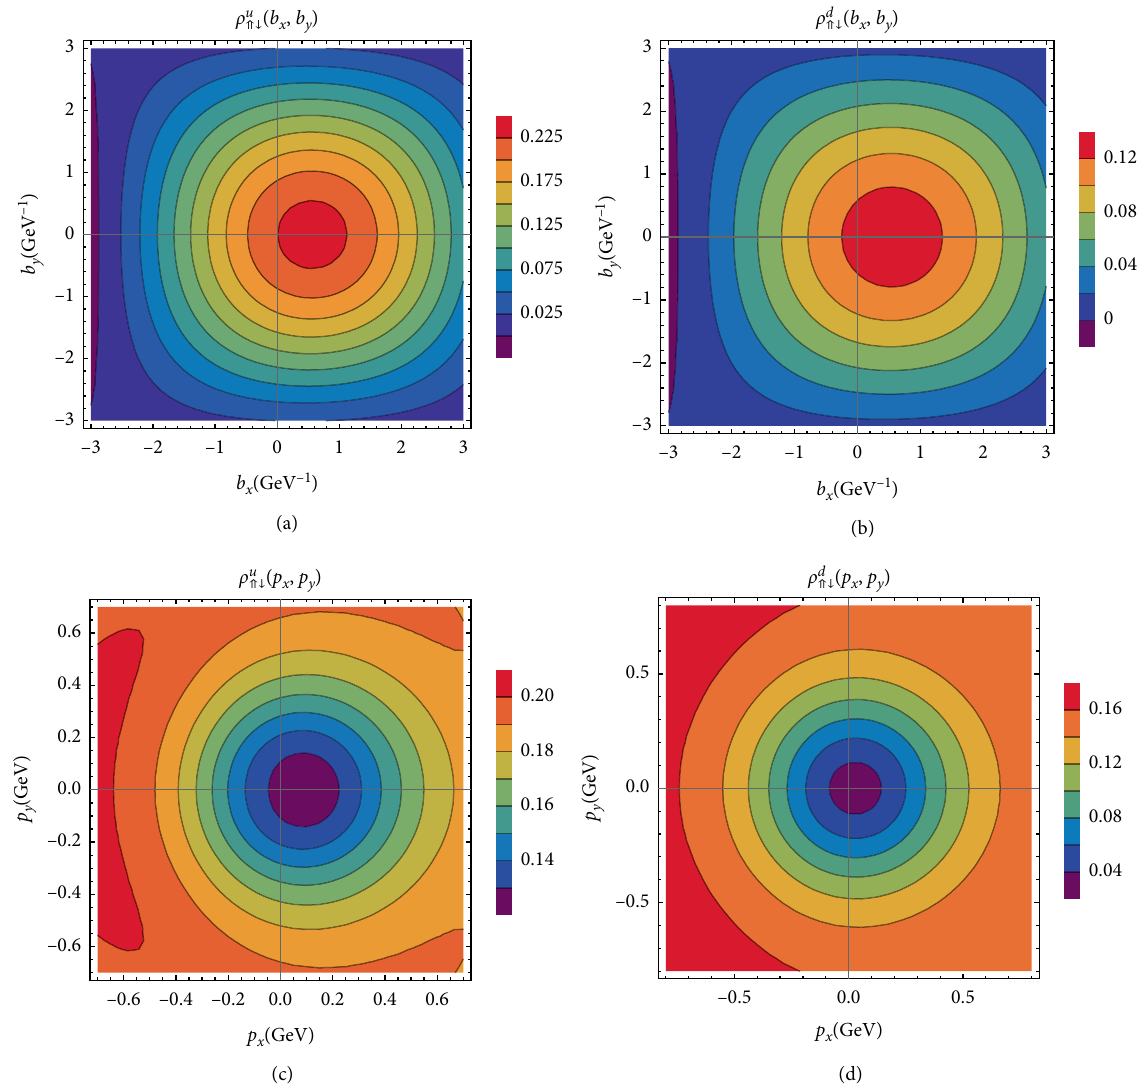
Figure 8: The plot of Wigner distribution 휌 (left panel) and 𝑑 -quark (right